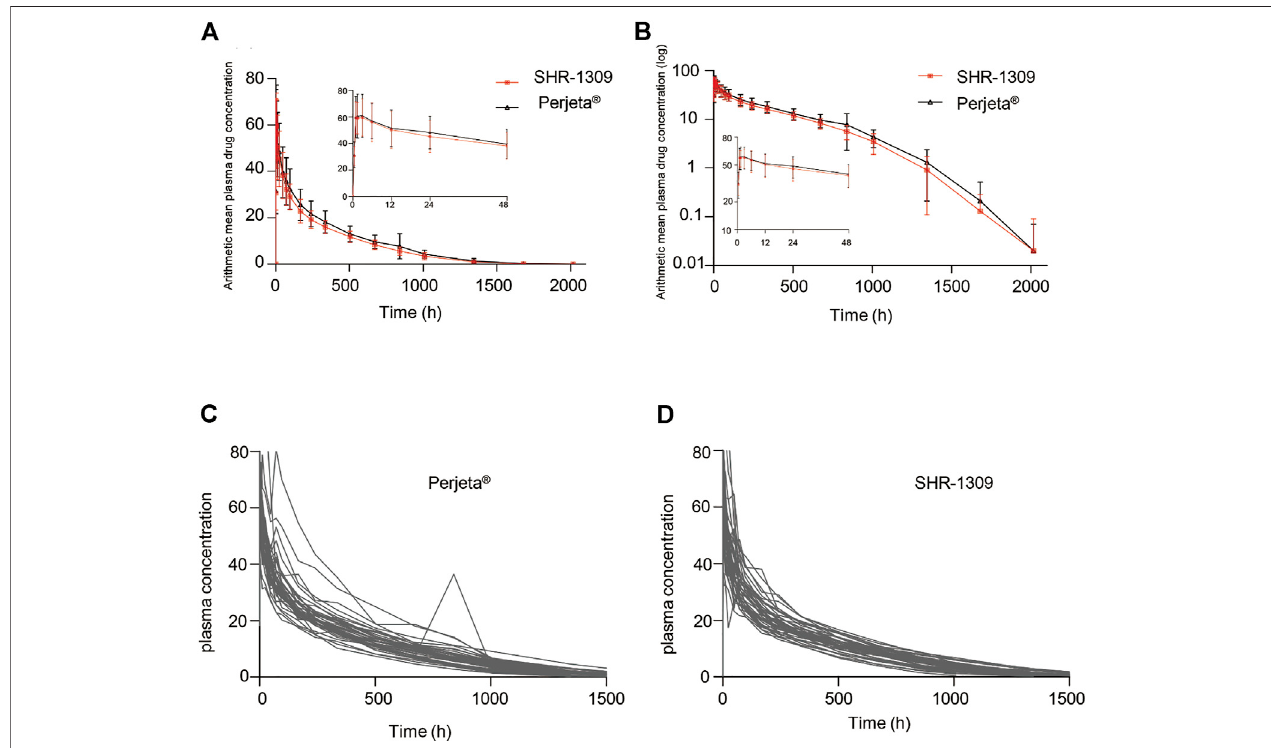
FIGURE2| Meanbloodconcentrationtimecurve. (A) Meanplasmaconcentration( ± SD)timecurveafterintravenousdripofSHR1309orPerjeta ® . (B) Logarithmic transformation of the mean plasma concentration ( ± SD) time curve after intravenous dripping of SHR1309 or Perjeta ® . (C) Plasma drug concentration time curve of 39 subjects after intravenous drip of Perjeta ® . (D) Plasma drug concentration time curve of 40 subjects after intravenous drip of SHR1309.